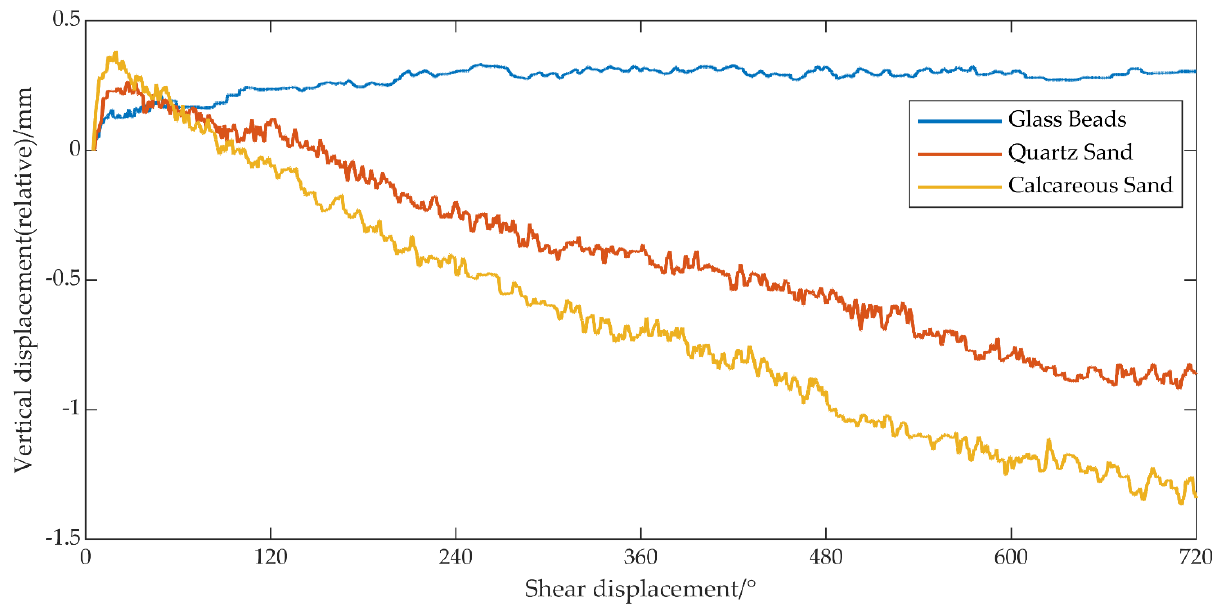
Figure 3. Vertical displacement versus shear displacement of glass beads, quartz sand, and calcareous sand at the same shear velocity.